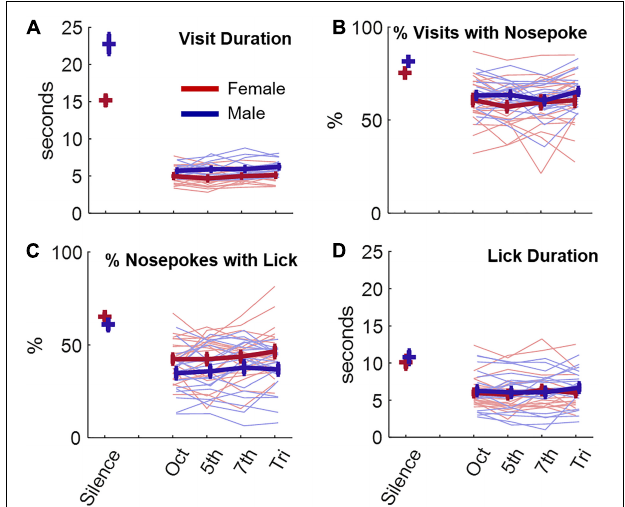
FIGURE 2 | Effects of listening to consonant or dissonant chords on behavior. (A) Visit duration in seconds as a function of the chord presented or during silence. The behavior of female (red) and male (blue) animals is displayed. Thin lines are individual data while thick lines display average +/– standard error bars. (B–D) Same as (A) for the percentage of nosepoking during each visit (B) , for the percentage of licking during each nosepoke (C) , and for the lick duration (D)